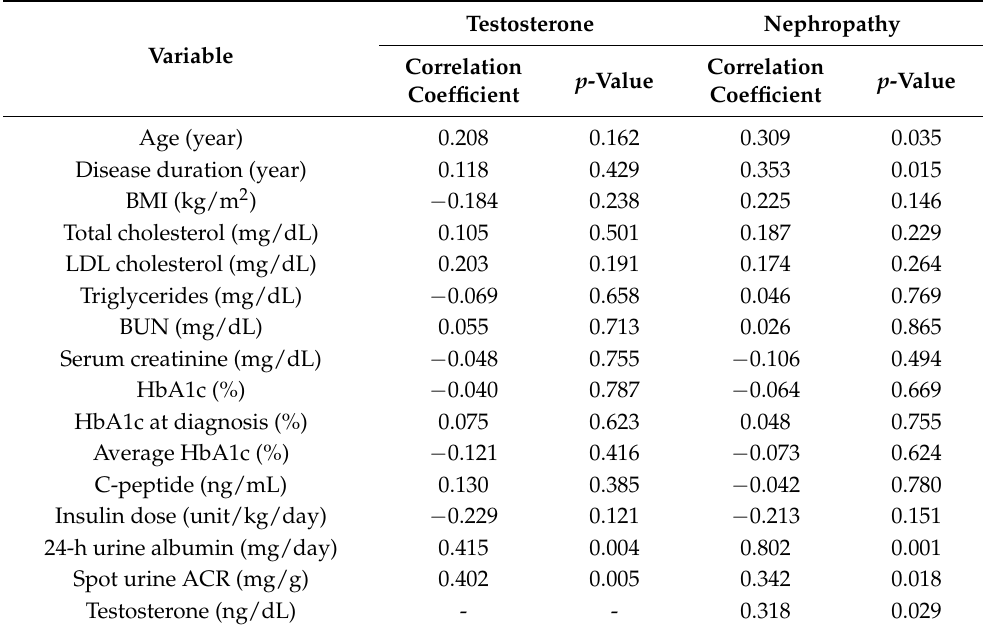
Table 2. Pearson’s correlation analysis for testosterone levels, nephropathy, and clinical variables in the study